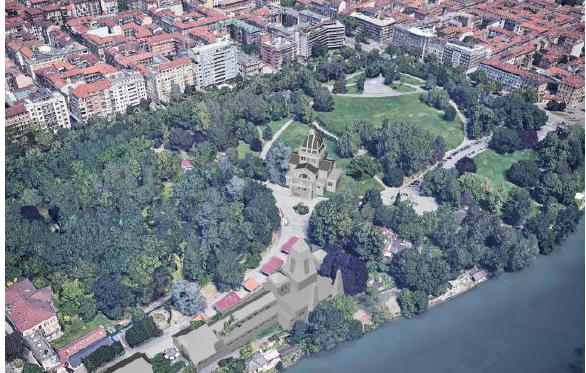
Figure 17. Reconstructed models of the Pavilions of Hungary and City of Turin visualized in the actual context of the